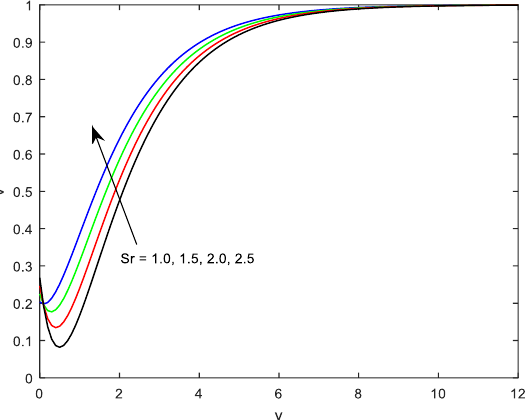
Fig. 3. Profiles of V with a change in S